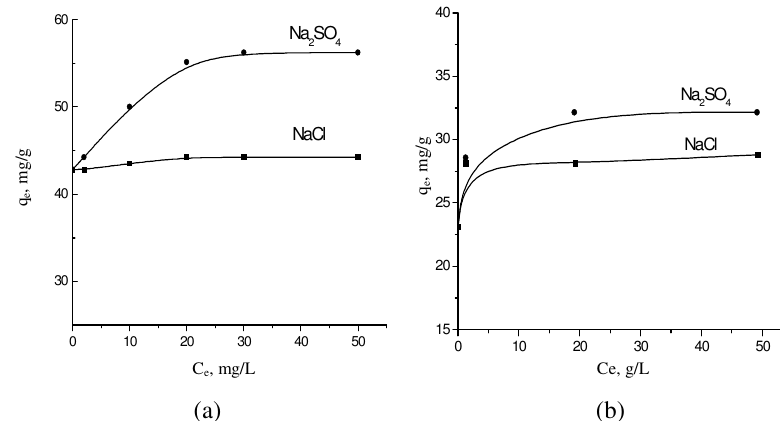
Figure 3. Influence of ion strength on adsorption capacity of EG for PEG (10000) (a), PEG (20000) (b) at 25 o